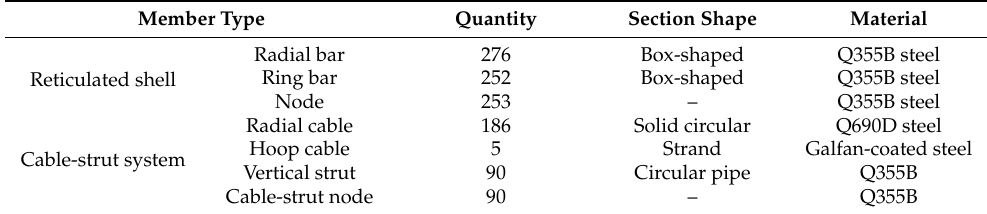
Figure 4. The suspen-dome structure of Lanzhou Olympic Sports Center: ( a ) Single-layer reticulated shell; ( b ) Cable-strut system; ( c ) The composition of the structure; ( d ) The center-hung scoreboard. Table 1. Information of components.